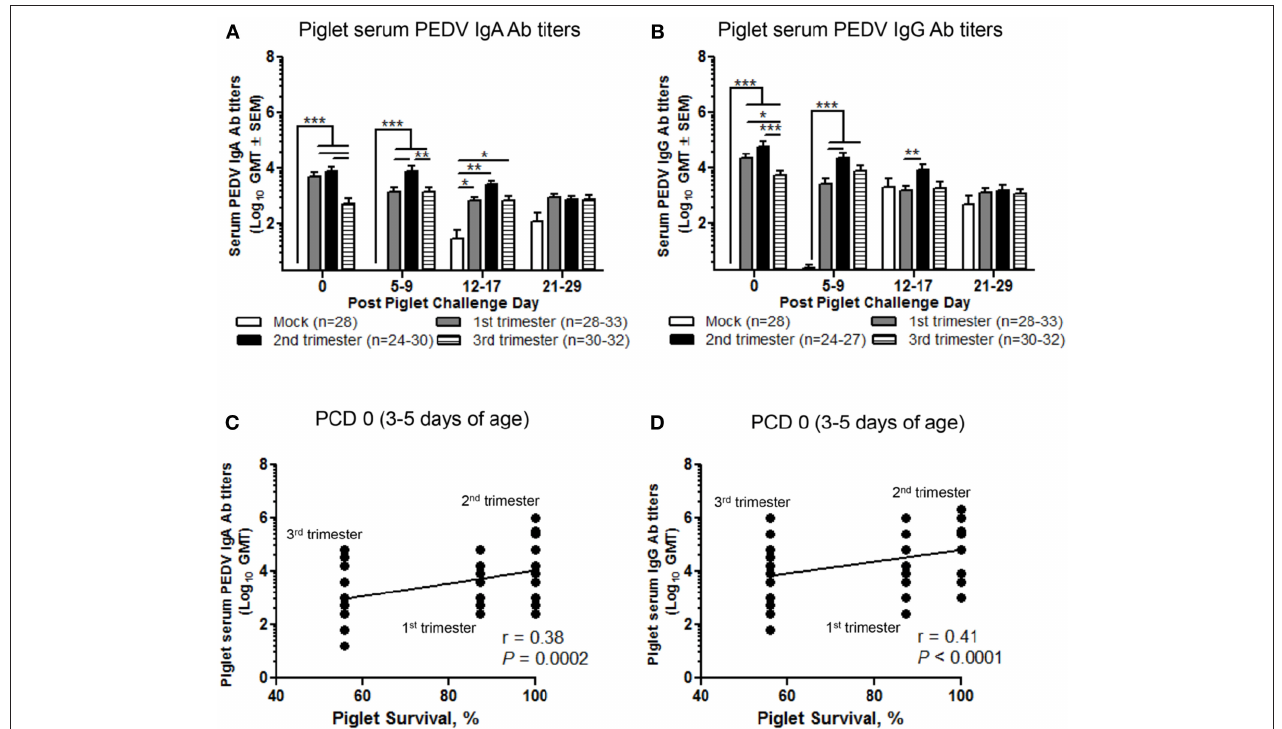
FIGURE 8 | Second trimester litters had the highest peak titers of circulating PEDV IgA and IgG antibodies (Abs) correlating with piglet protection post PEDV challenge. (A) Serum PEDV IgA and (B) IgG Ab responses were determined by PEDV ELISA assay. Piglet survival rates were significantly positively correlated with circulating PEDV (C) IgA and (D) IgG Abs at post challenge day (PCD) 0. Piglets were sampled at PCD 0, 5–9, 12–17, and 21–29. Asterisks indicate significant differences among treatment groups at the same time point (mean ± SEM). Statistical analysis was performed using the two-way ANOVA with repeated